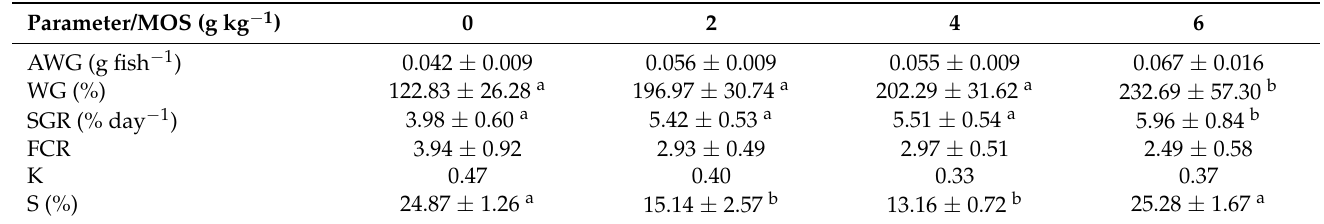
Table 3. Growth parameters in MOS-fed larvae. Superscript letters indicate differences between groups ( p > 0.05). For the measurements, 30% of the larvae in each tank were considered.